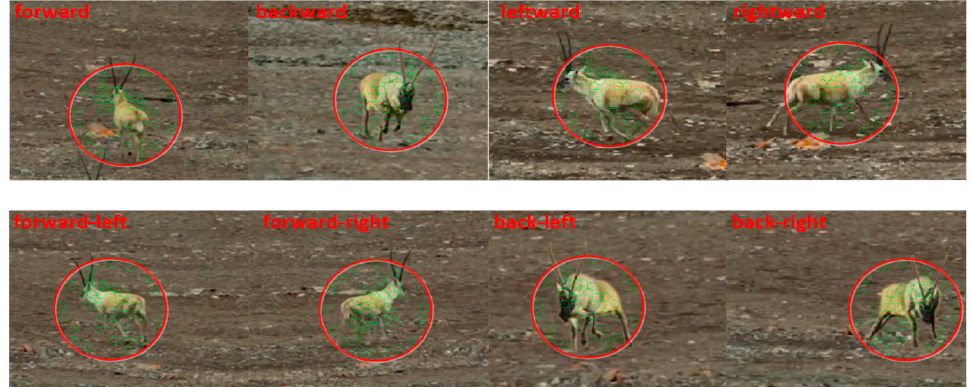
Figure 9. Computation for the motion direction of Tibetan antelopes in eight directions by the proposed algorithm.